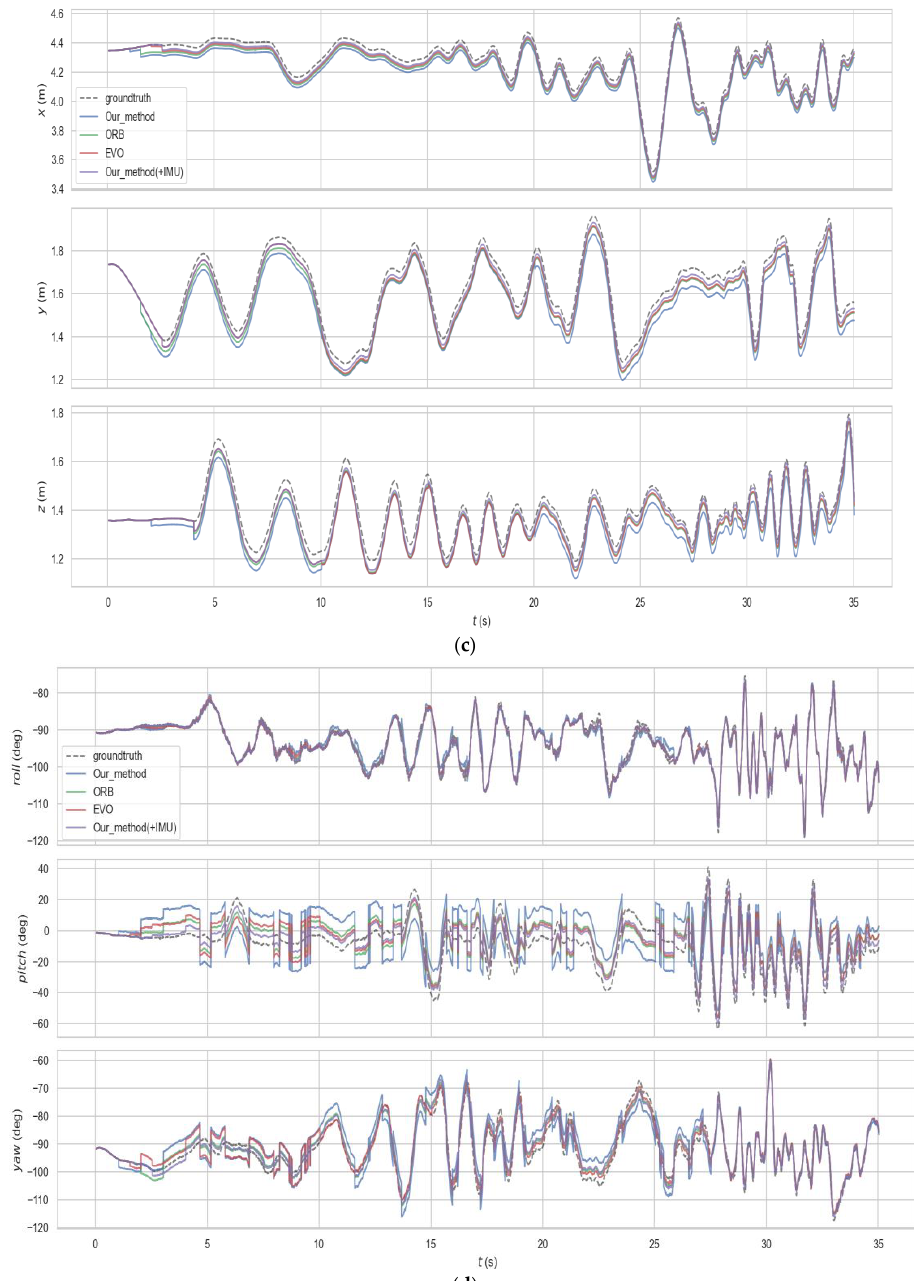
Figure 6. VO Experiment 2 (boxes_6dof): ( a ) 3D event camera trajectories estimated by different algorithms; ( b ) Comparison of absolute pose errors between different algorithms; ( c ) The translation position of the camera estimated by different algorithms; ( d ) The rotation position of the camera estimated by different algorithms.